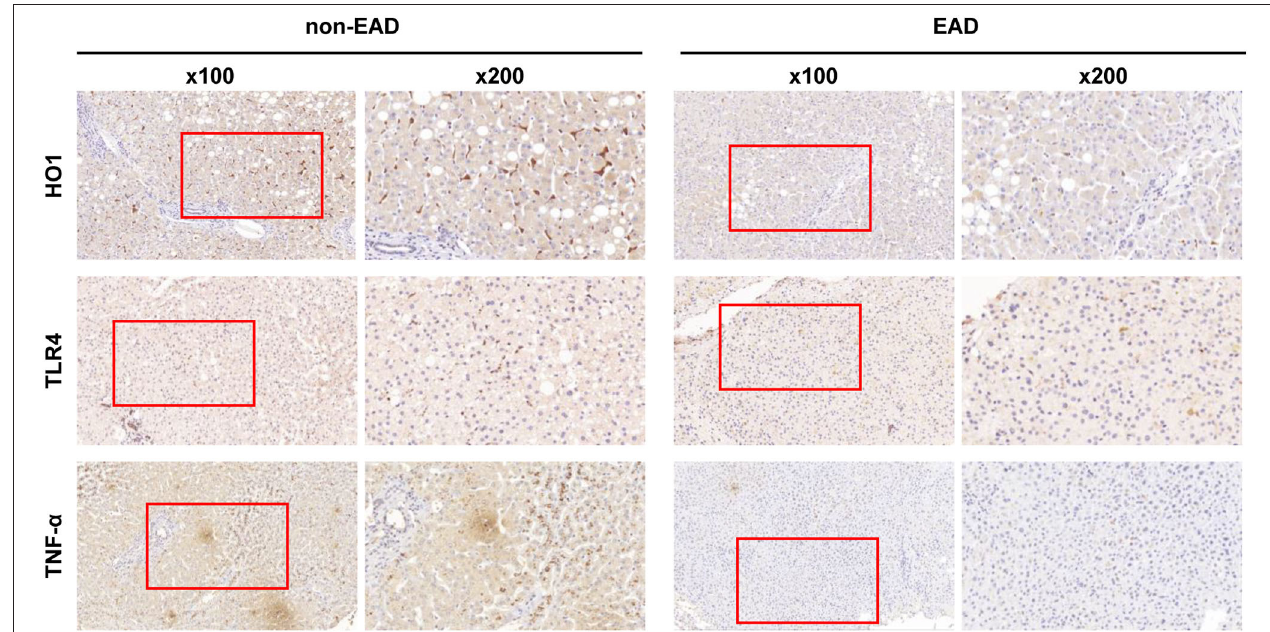
FIGURE 1 | Representative immunohistochemical results of the intrahepatic expression of HO1, TLR4, and TNF- α between EAD ( n = 44) and non-EAD ( n = 61) groups. EAD, early allograft dysfunction; HO1, heme oxygenase-1; TLR4, toll like receptor 4; TNF- α , tumor necrosis factor α .